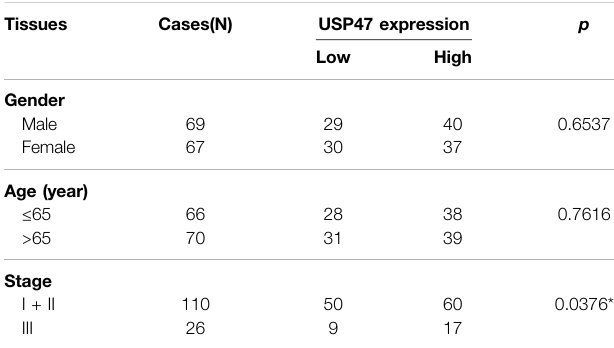
TABLE 2 | Correlation between USP47 levels in CRC patients and their clinicopathologic characteristics.